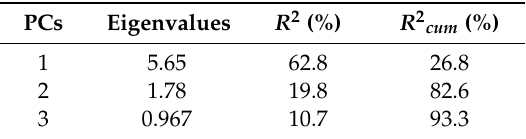
Table 5. Diagnostics of the principal component analysis (PCA) model on data Block M . PCs